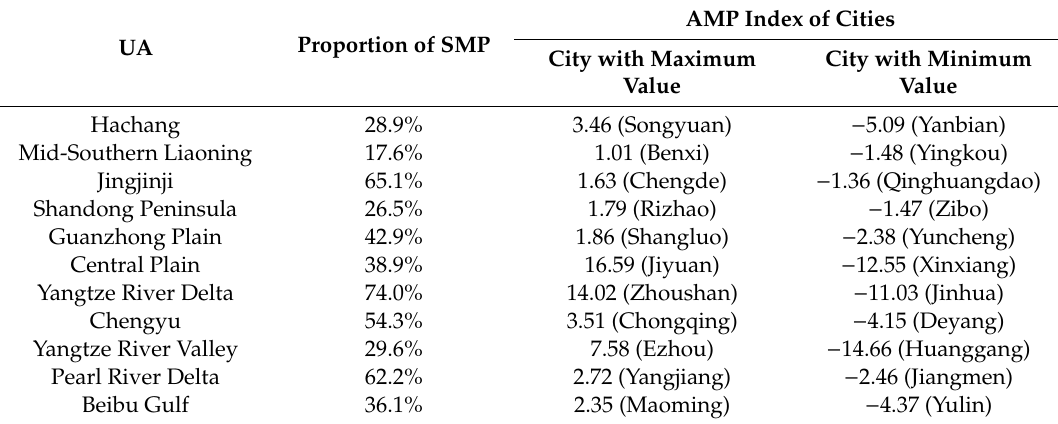
Table 5. Symbiotic characteristics of the 11 UAs.